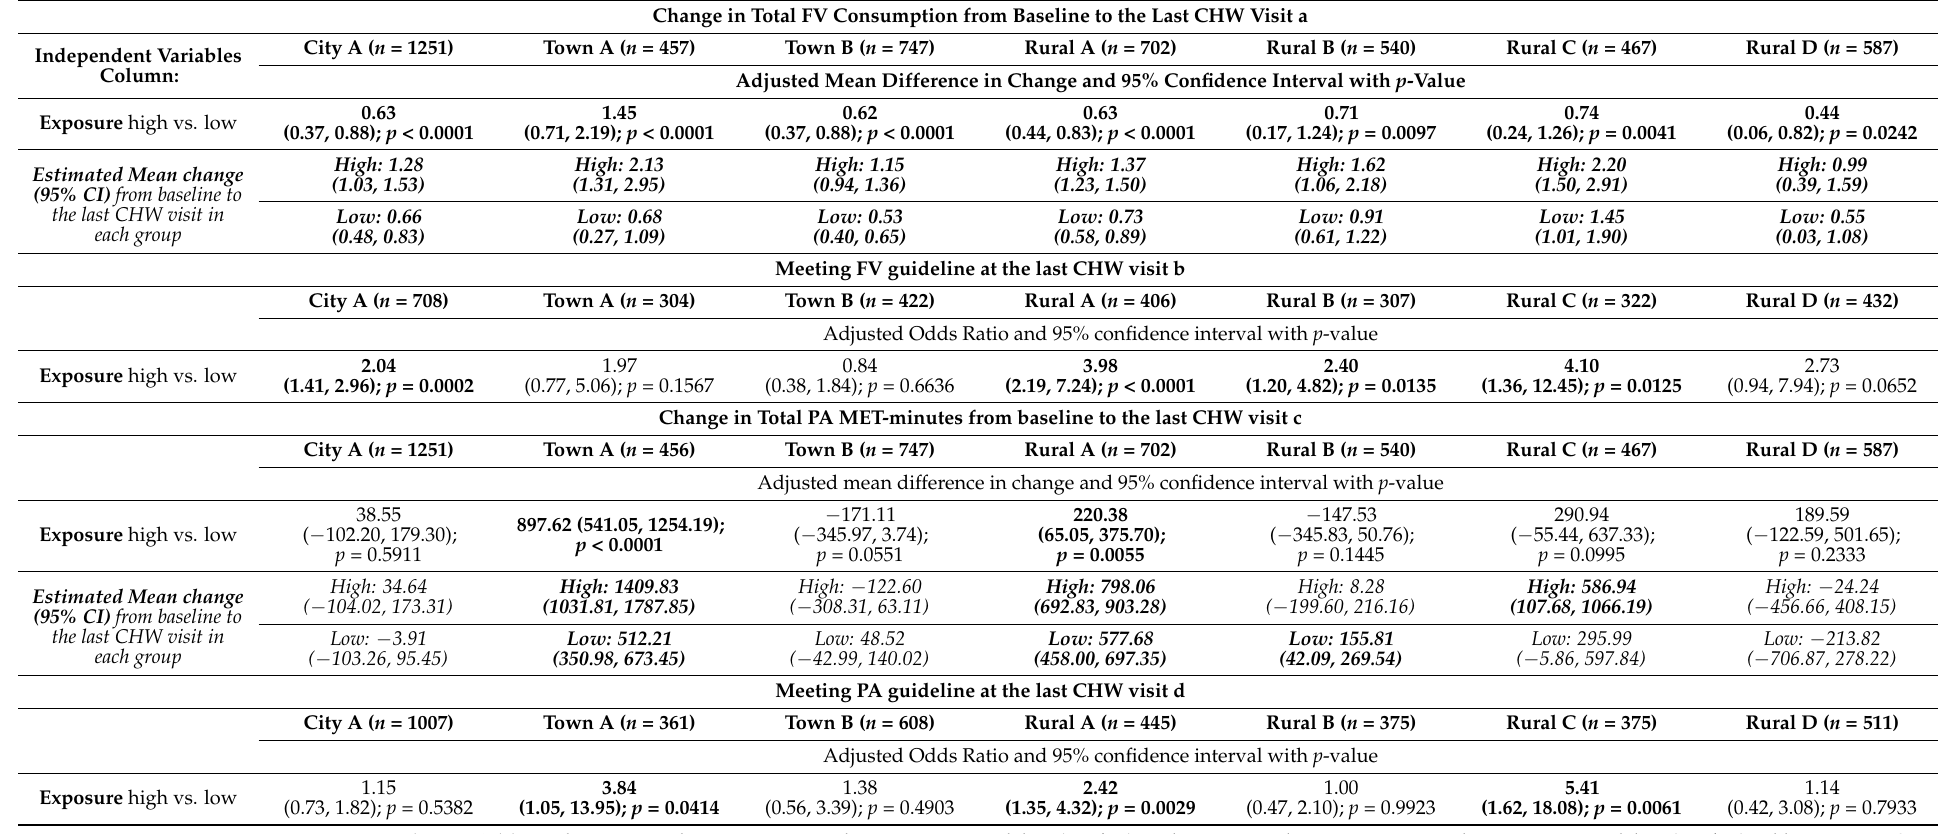
Table 5. TSSC program effect on change in FV, PA MET-minutes and meeting FV, PA guideline by location ( n =